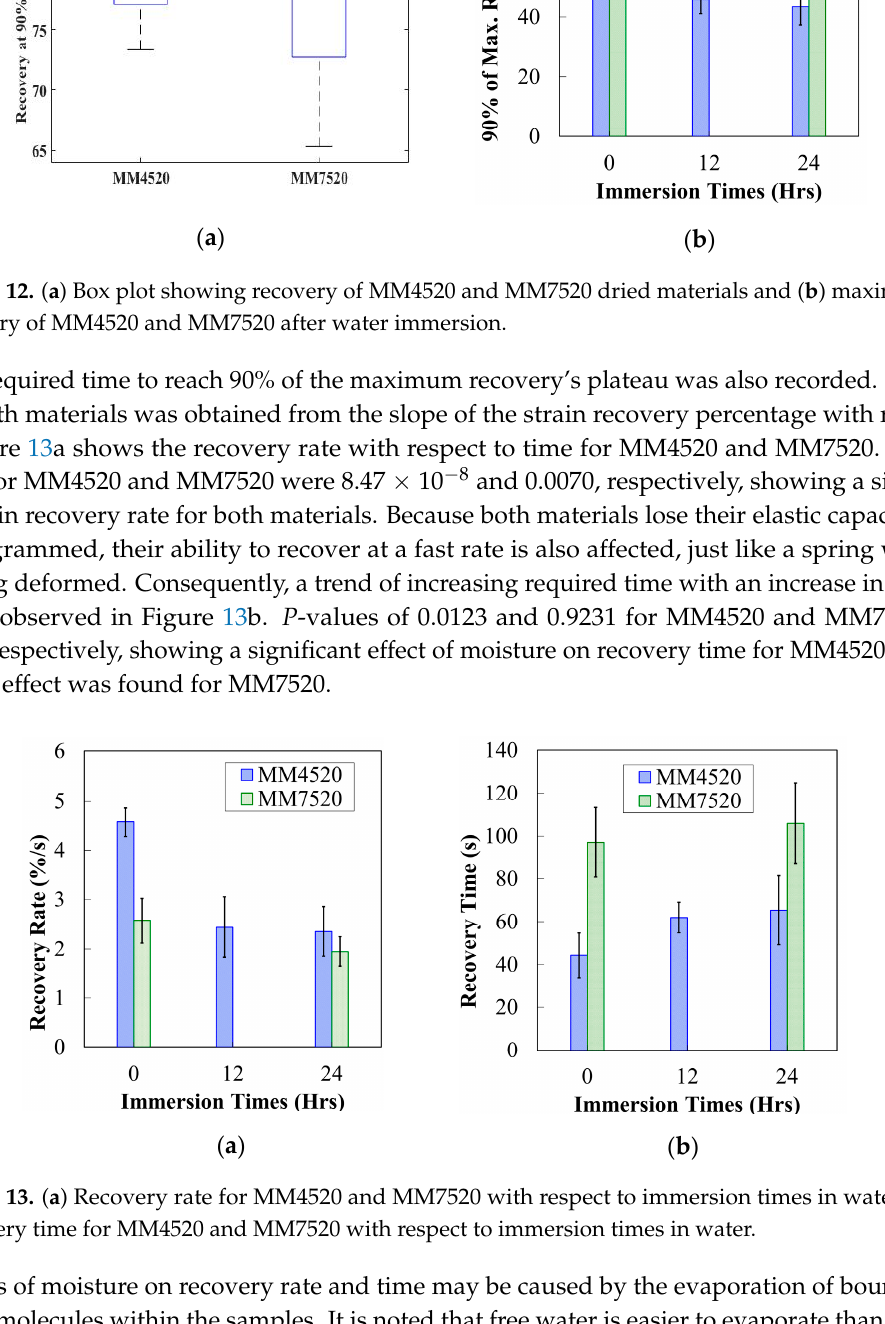
Figure 12. ( a ) Box plot showing recovery of MM4520 and MM7520 dried materials and ( b ) maximum recovery of MM4520 and MM7520 after water immersion.